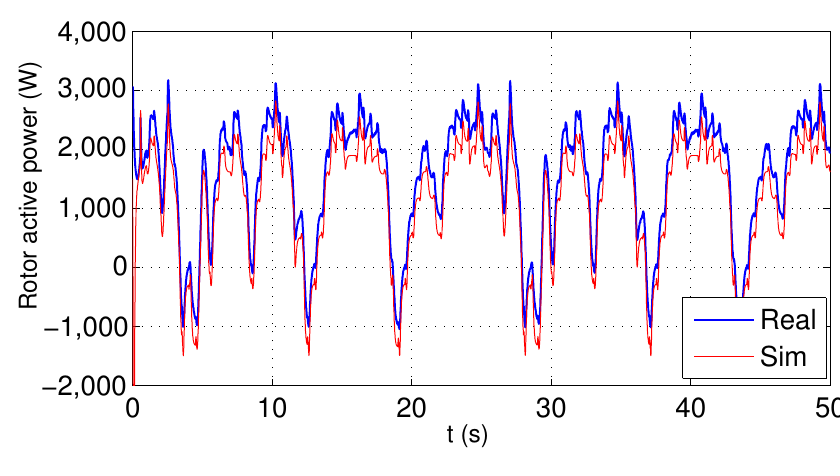
Figure 8. Real and simulated rotor active